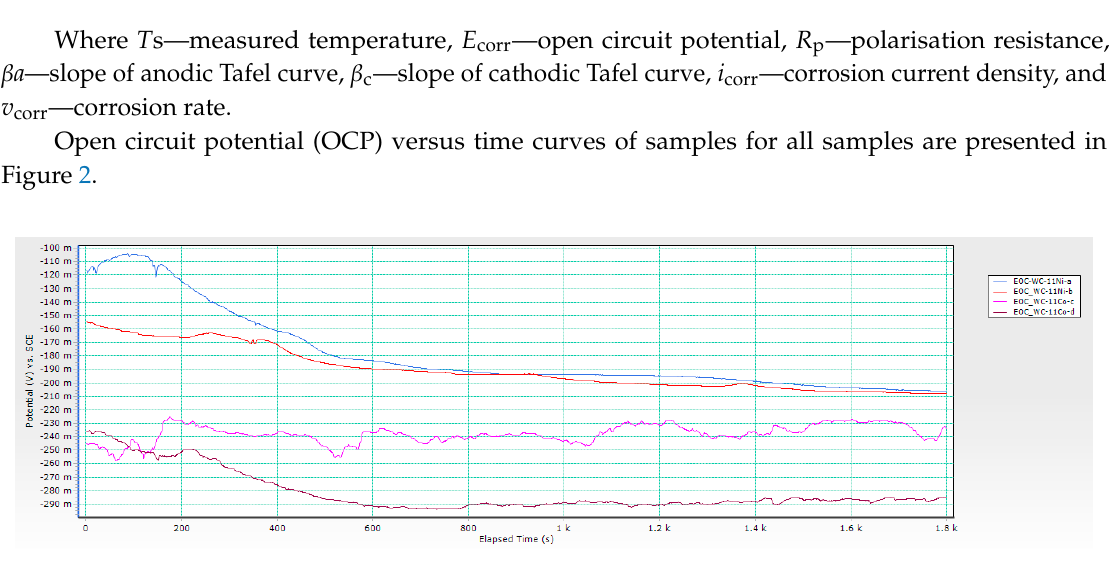
Figure 2. Open circuit potential (OCP) versus time curves of samples.